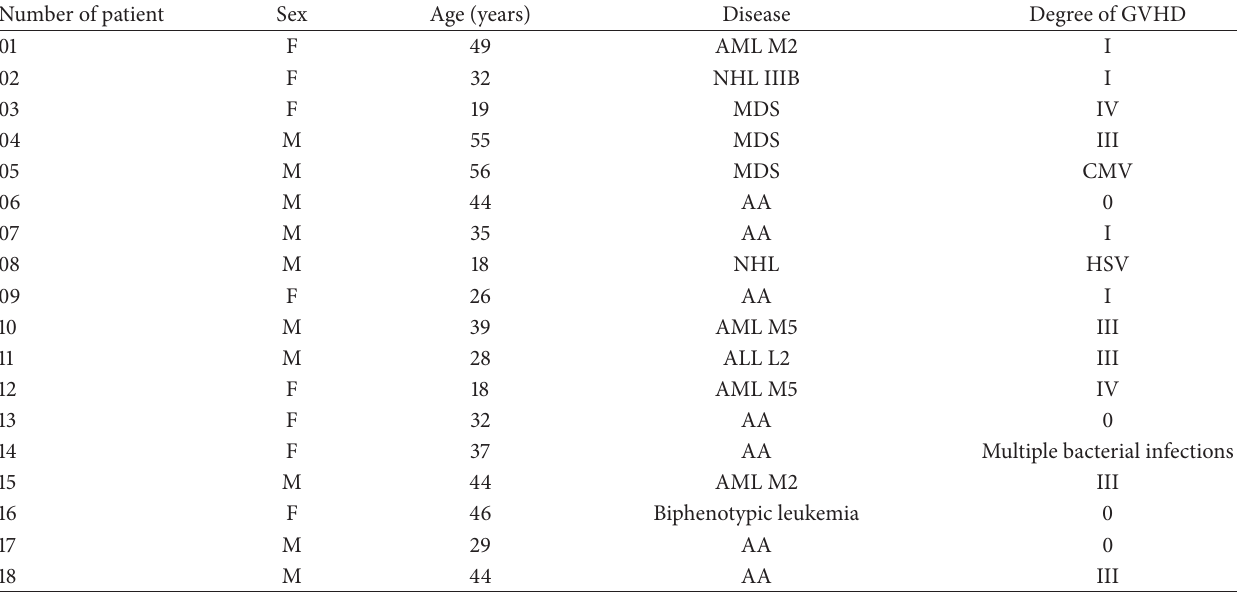
Table 1: Patient